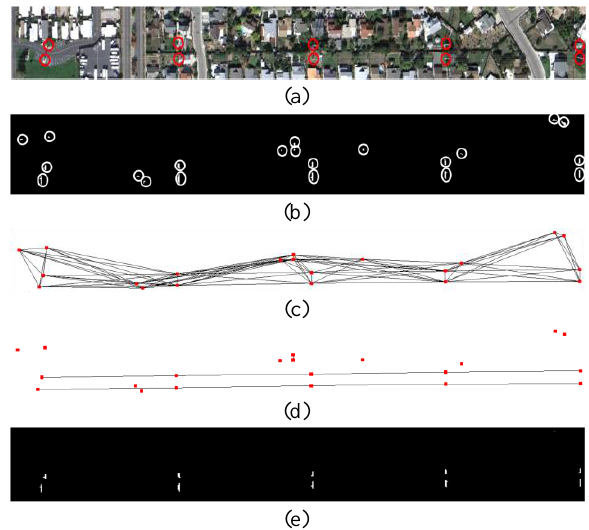
Figure 4. Pylon validation procedure; (a) true pylon position, (b) detected pylon segments, (c) possible segment connections (edges), (d) remained P-P edges, and (f) pylon detection final